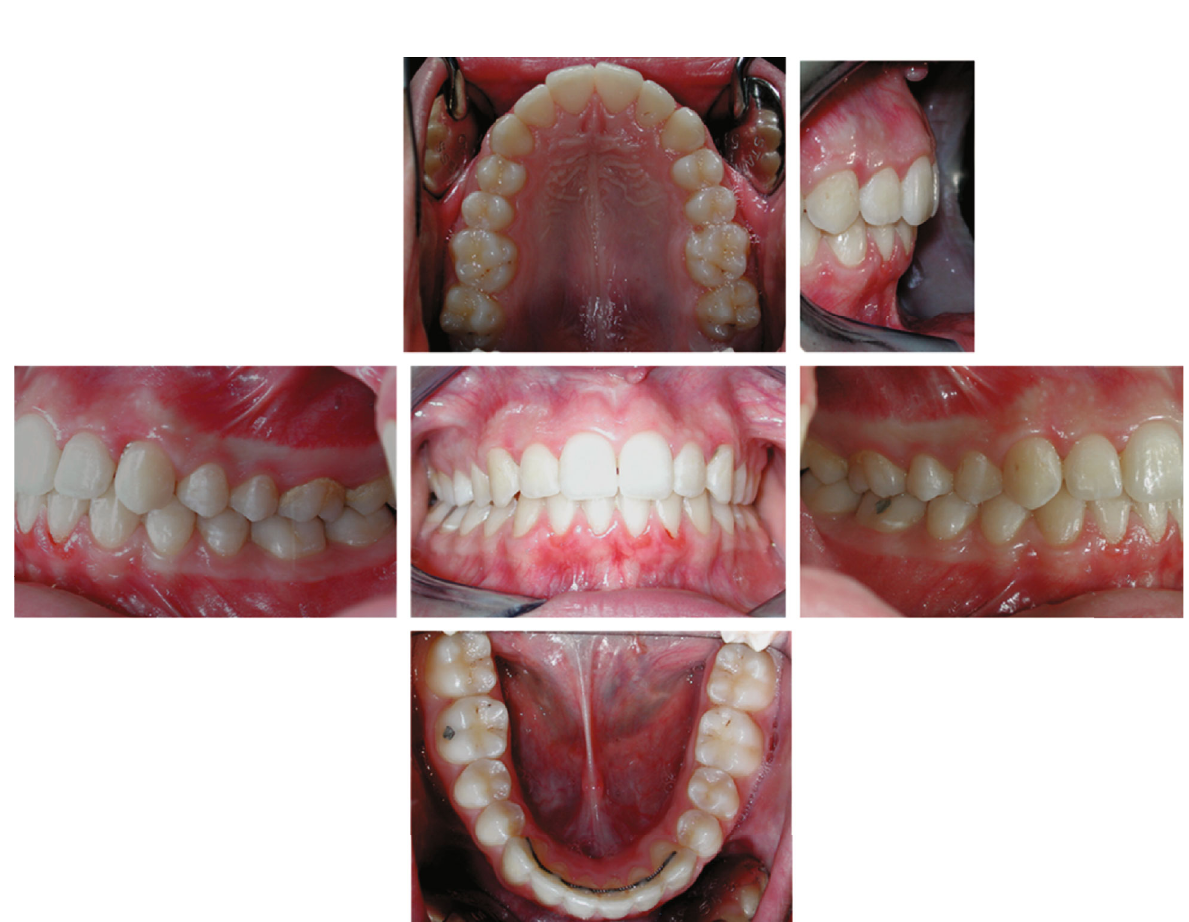
Figure 10: 2-year follow-up intraoral